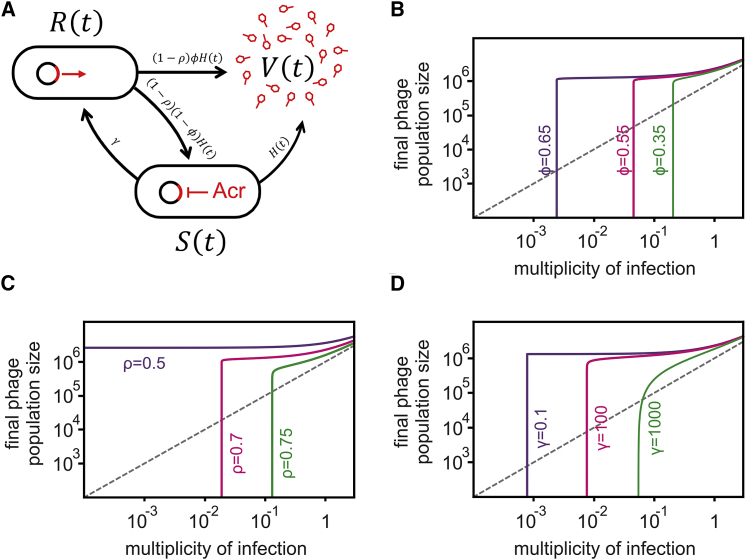
Epidemiological Tipping Points Can Result from Cooperation between Sequentially Infecting Acr-Phages(A) Infection model of the Acr-phage (see details of the model in STAR Methods). The parameter H(t) = αV(t) refers to the rate at which bacteria are infected by free phage particles.(B) Effect of initial Acr-phage inoculum density on the phage density at 24 hpi for different values of Acr efficacy (purple, ϕ = 0.65; magenta, ϕ = 0.55; green, ϕ = 0.35); other parameter values: B = 5, α = 0.001, ρ = 0.7, γ = 20.(C) Effect of initial Acr-phage inoculum density on the phage density at 24 hpi for different values of CRISPR efficacy (ρ = 0.5, 0.7, and 0.75; purple, magenta, green, respectively); other parameter values: B = 5, α = 0.001, ϕ = 0.6, γ = 20.(D) Effect of initial Acr-phage inoculum density on the phage density at 24 hpi for different values of the duration of the immunosuppressive state (γ = 0.1, 100, and 1,000; purple, magenta, green, respectively); other parameter values: B = 5, α = 0.001, ϕ = 0.65, ρ = 0.7. In all graphs, gray lines correspond to the initial amount of phage, and values below this line indicate a lack of phage amplification.See also Figure S4.